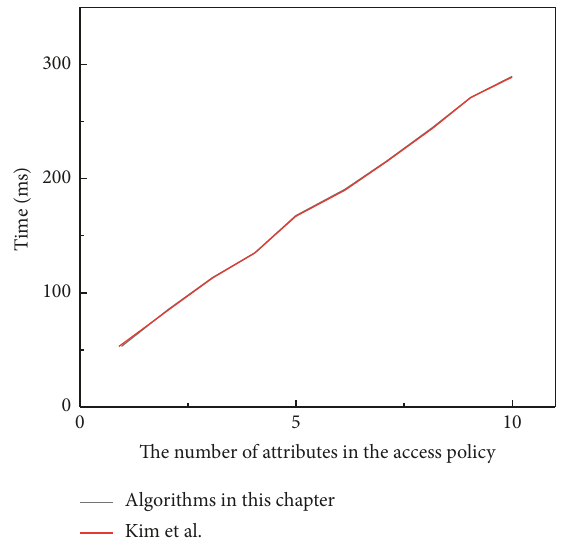
Figure 9: Decryption time of attribute encryption algorithm with hidden and verifiable policy.